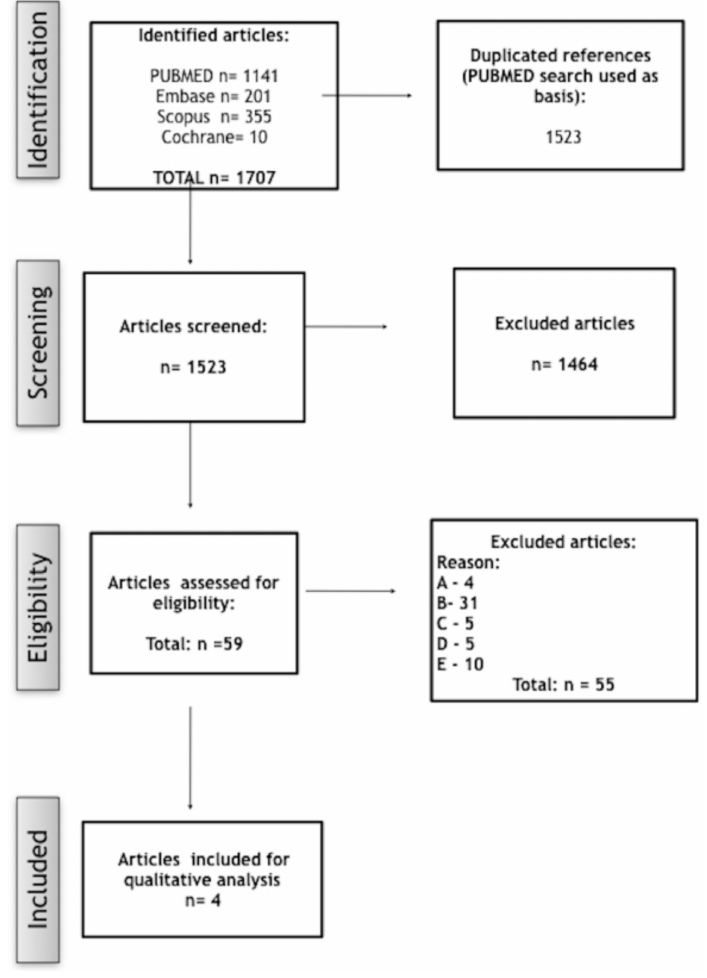
Figure 1. Fluxogram showing the search strategy.